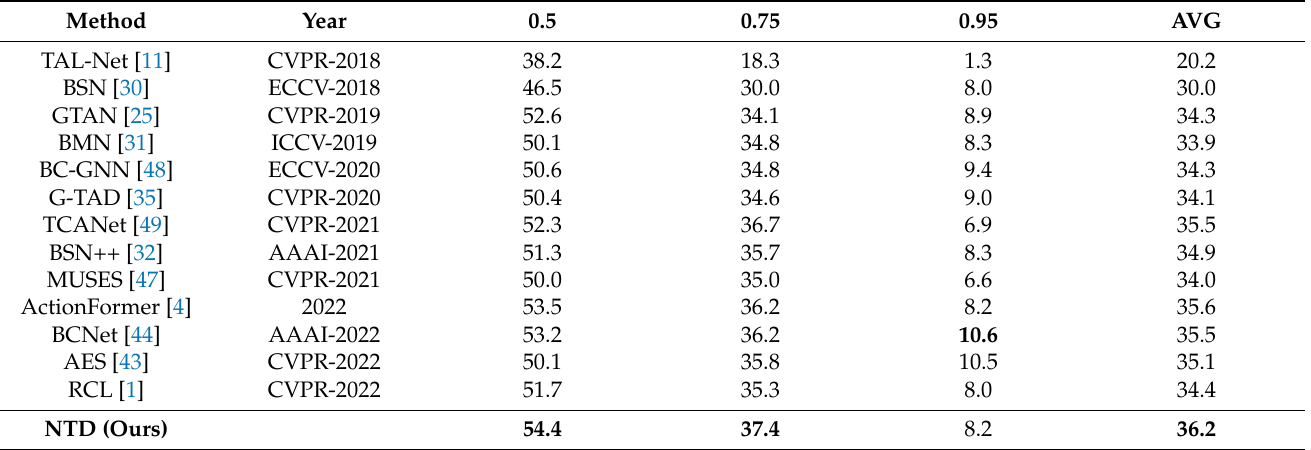
Table 2. Comparison with state of the art (ActivityNet-1.3). We report the precision at tIoU = 0.5, 0.75, and 0.95 (mAP@tIoU) as well as average mAP in [0.5:0.05:0.95] (mAP@avg). The best results are in bold.